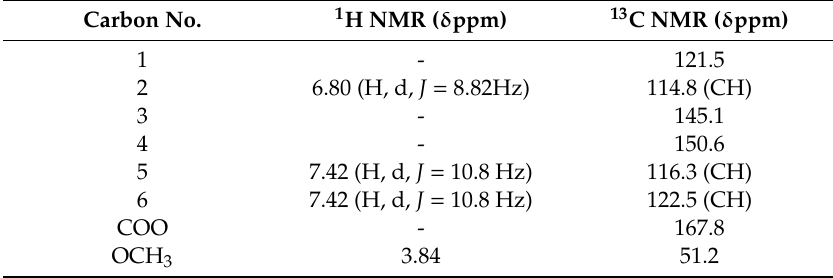
Table 3. The 1 H and 13 C NMR spectral data (recorded in CD 3 OD) of BV3 fraction isolated from Bauhinia variegata L. bark.